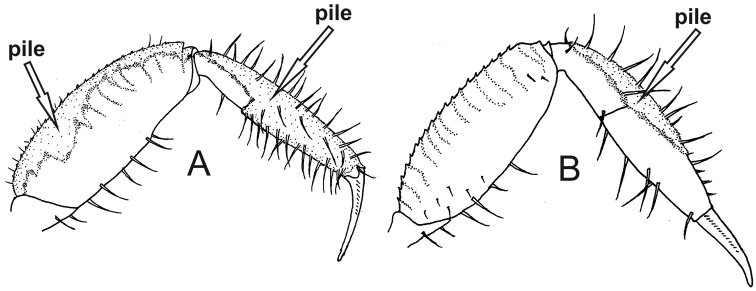
Third ambulatory leg, posterior view. AMinuca
mordax with pile on dorsal surface of merus (seta) and carpus and all around surfaces of manus (seta) BMinuca
burgersi with pile limited to dorsal surface of carpus and manus (seta).